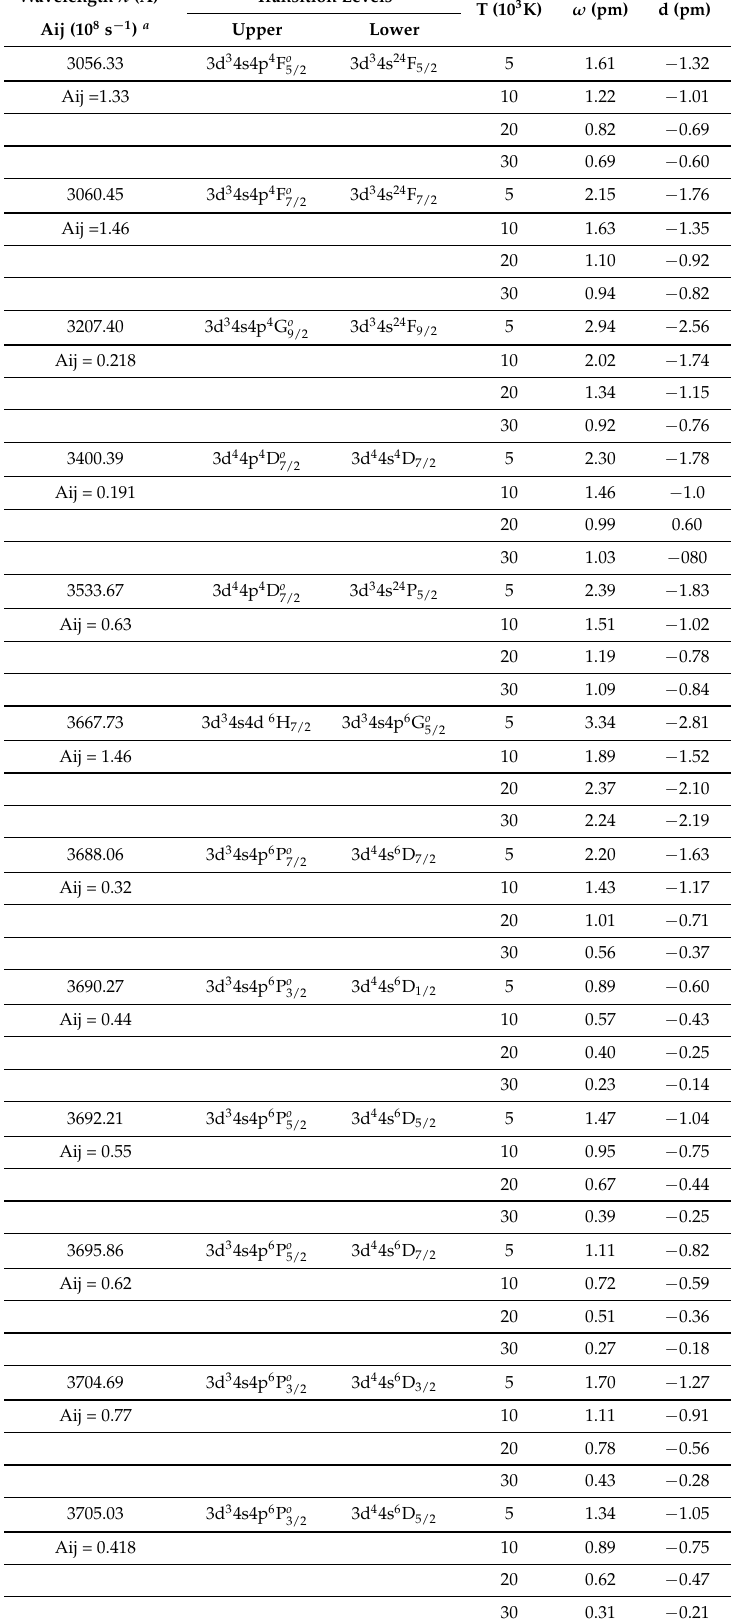
Table 2. Neutral vanadium (V I) line-widths (FWHM), ω (pm), and shifts (d(pm)) normalized to Ne = 10 15 cm − 3